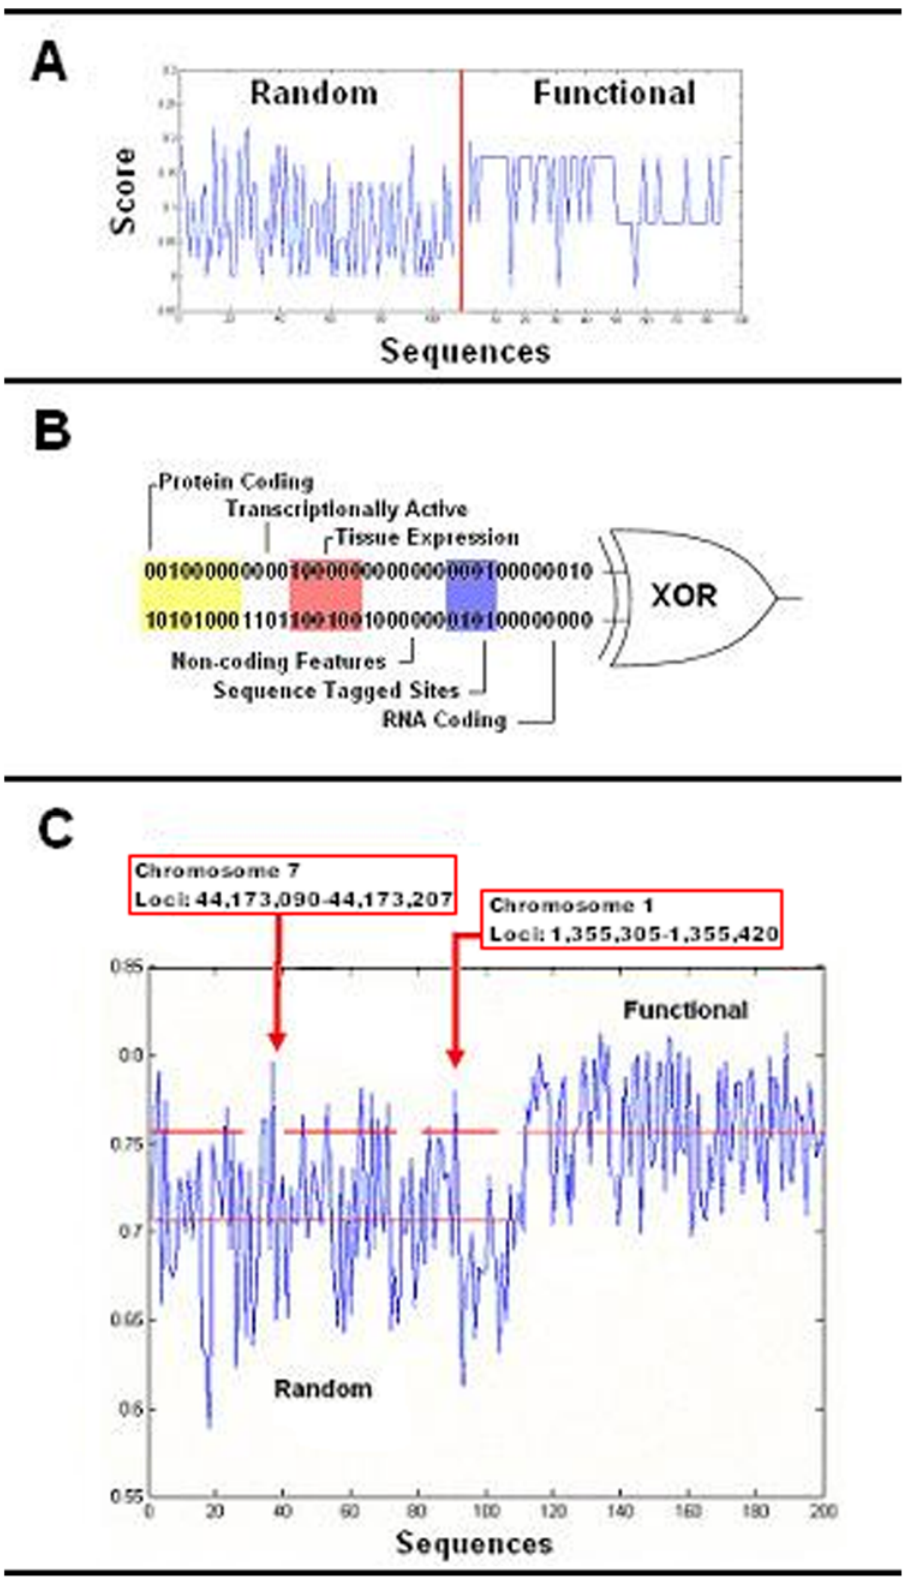
Figure 1. Analysis of bit encoded genomic sequences. (a) Each sequence (point) is evaluated against every other sequence outputting a binary vector which is summed and normalized. The correlation coefficient was performed on random and functional vectors (t=6.19, f=15.17, df=201, p , 0.05). The correlation coefficient is a number between 0 and 1 and if there is no relationship between the compared sequences, then a value of 0